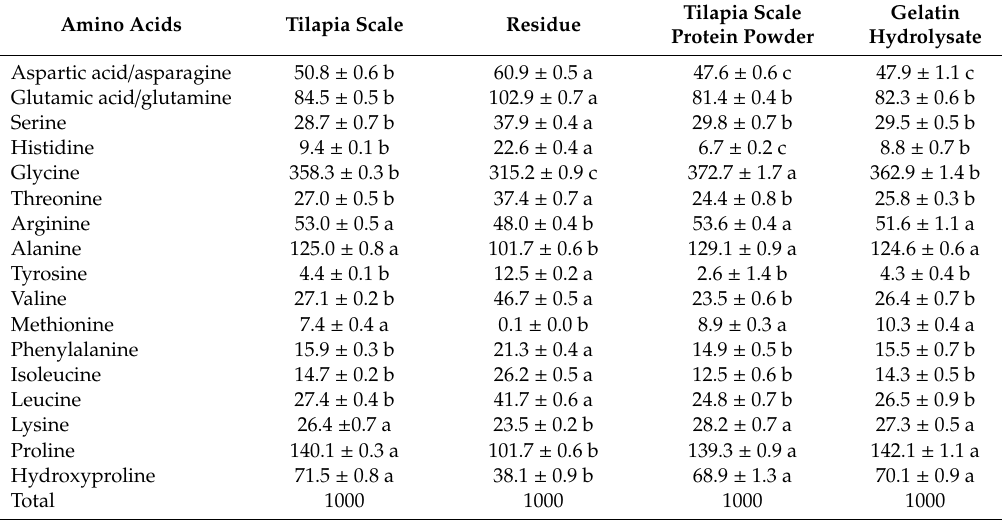
Table 1. Amino acids composition of tilapia scale, residue, tilapia scale protein powder, and gelatin hydrolysates (results are expressed as residues / 1000 total